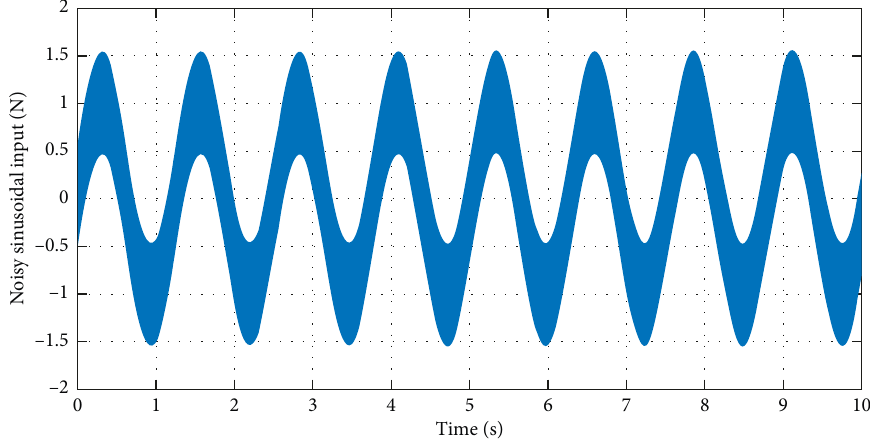
Figure 19: Noisy sinusoidal excitation force input u ∗ ( t ) .